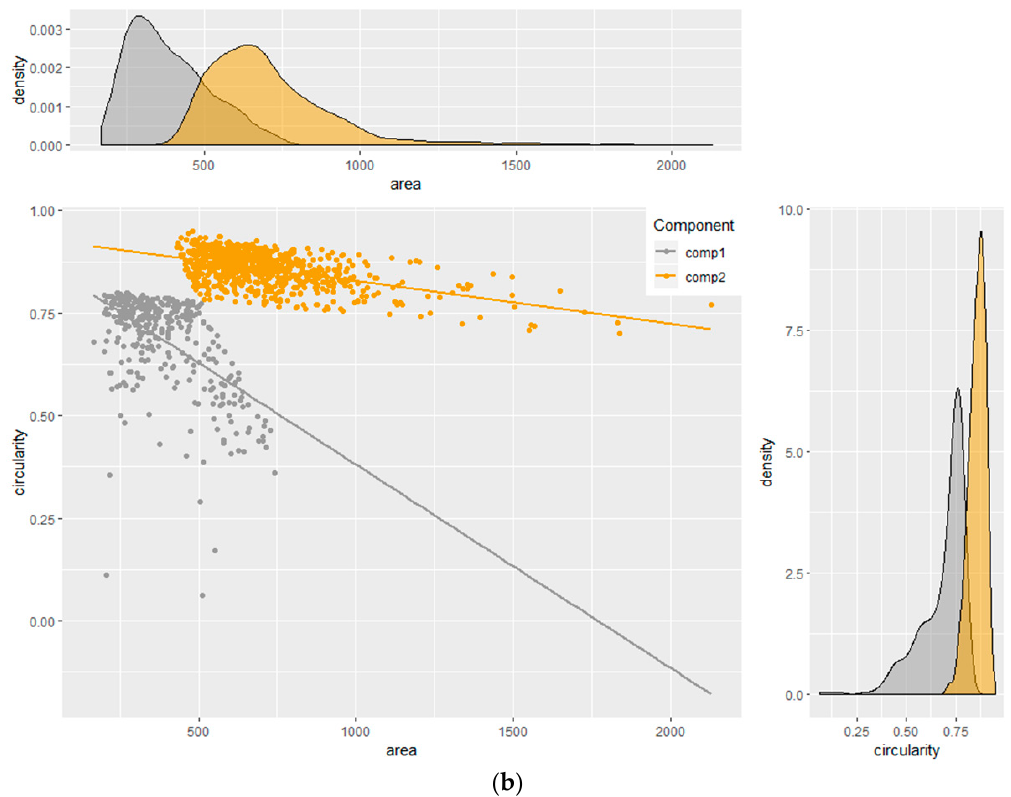
Figure 4. ( a ) Scatter plot of area (pixel 2 ) versus the circularity measurements of E coli bacteria. ( b ) Mixture of regression models of the area (pixel 2 ) versus circularity.